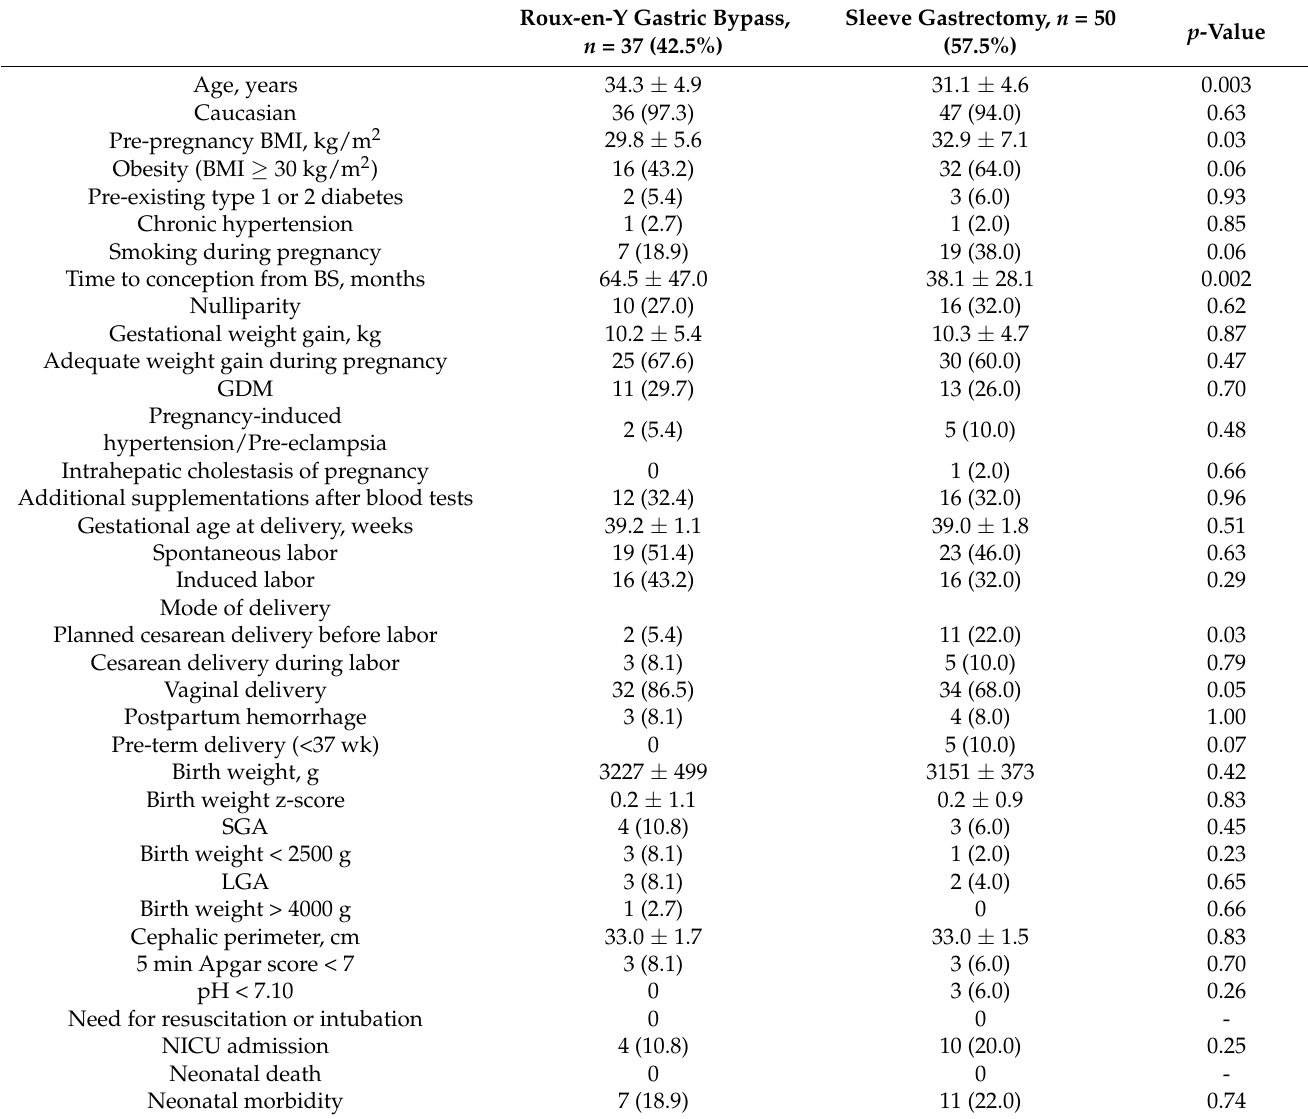
Table 1. Maternal characteristics and maternal and neonatal outcomes according to the type of bariatric